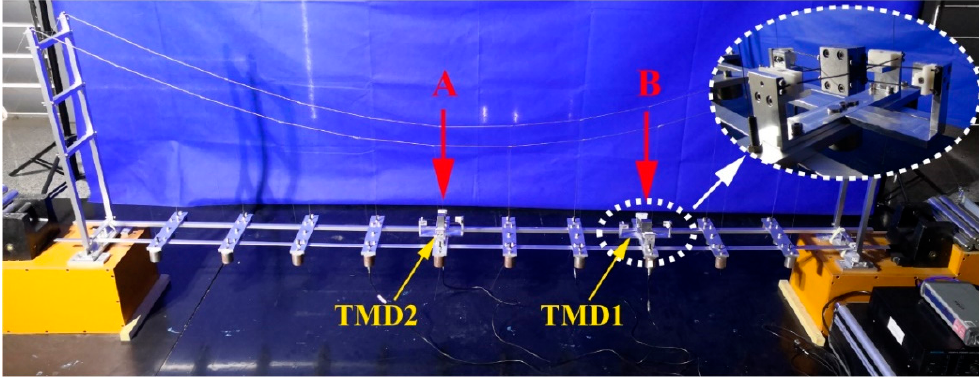
Figure 18. Experimental implementation of the 2DOFs TMDs. The damping is tuned by changing the magnets.